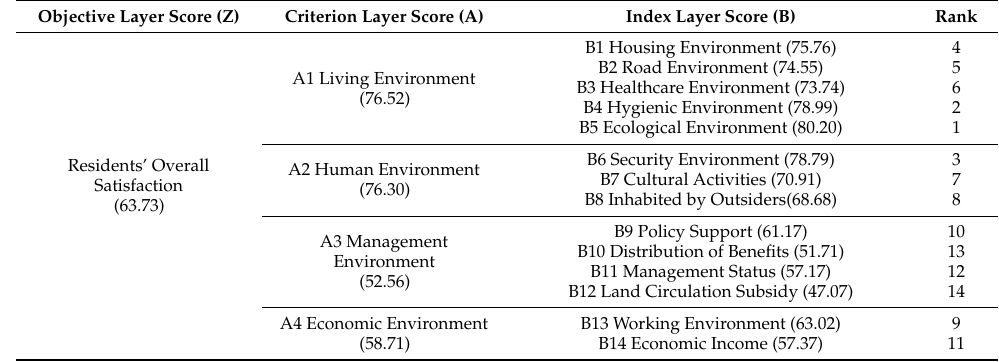
Table 3. Residents’ satisfaction scores with multi-dimensional environments in Tianquan Community.